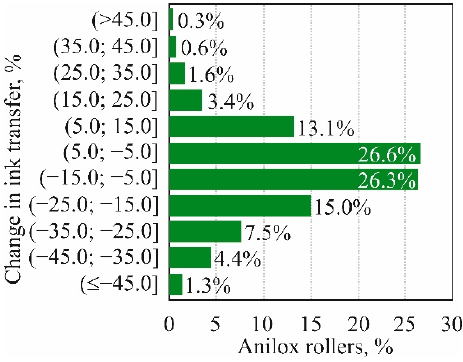
Figure 8. Distribution of anilox rollers according to the change in ink transfer.